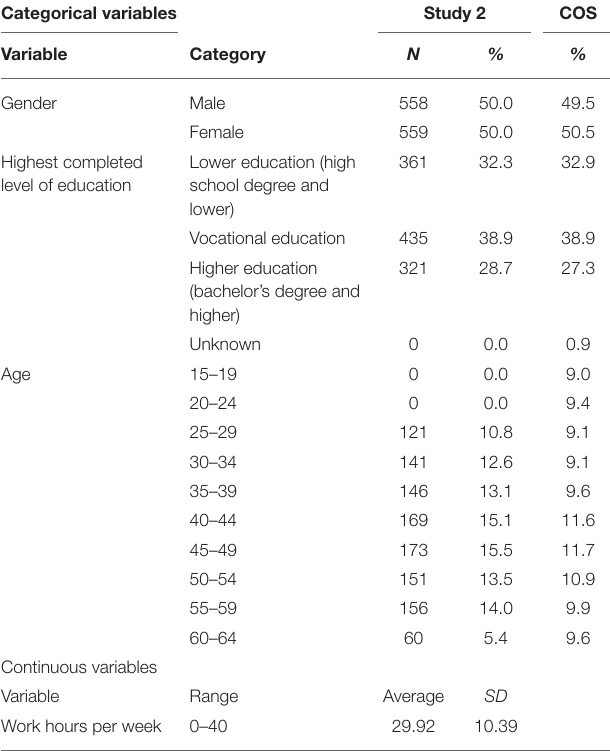
N = 1117. COS = Central Office for Statistics in the Netherlands.